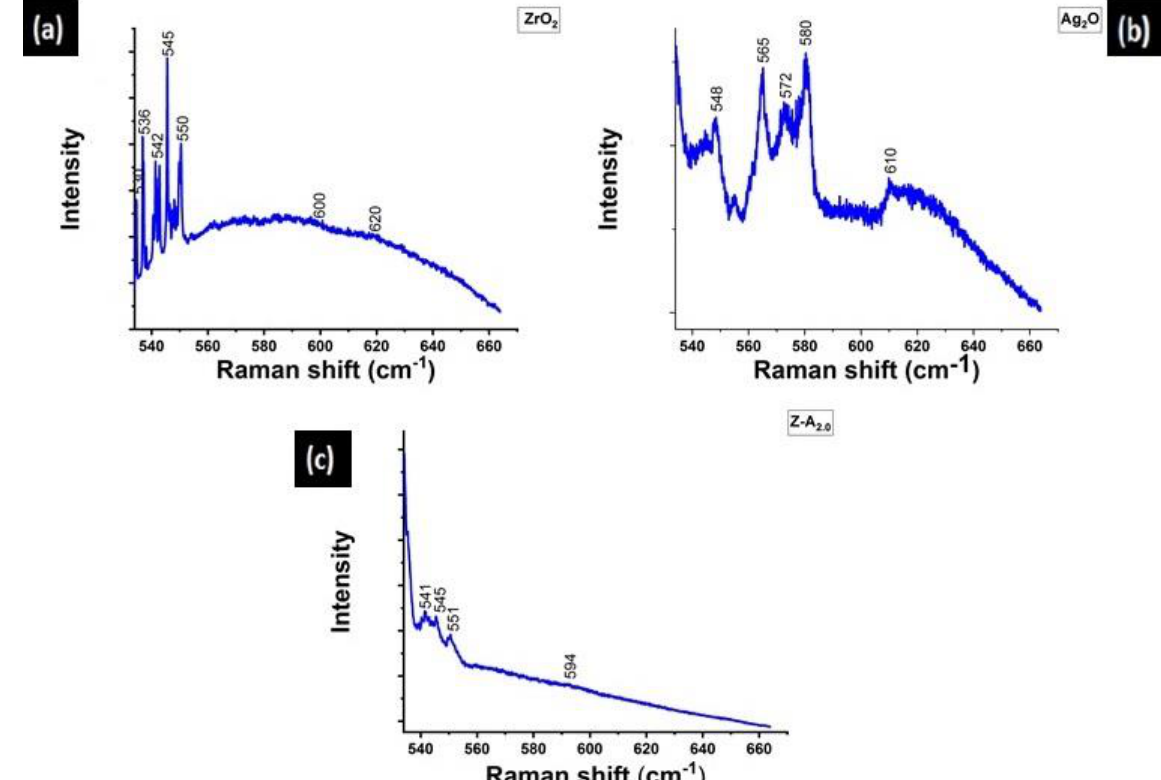
Figure 2. Raman spectra of ( a ) ZrO 2 ( b ) Ag 2 O and ( c ) Z-A 2.0 nanoparticles.